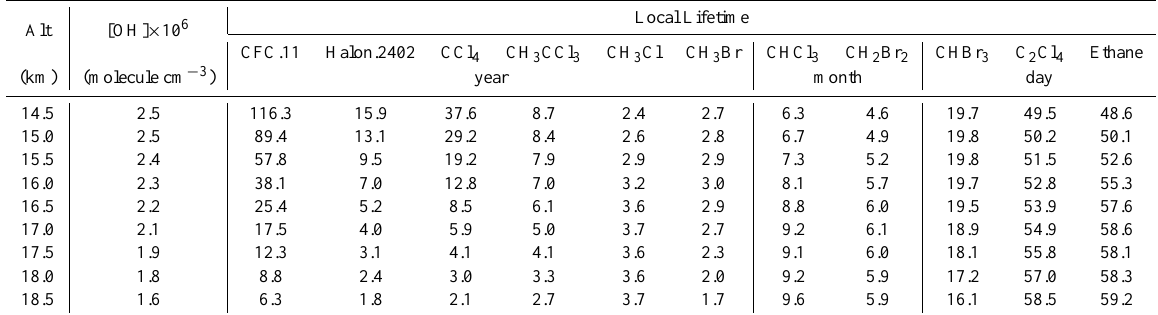
Table 1. Empirically derived OH concentrations with altitude (as shown in Fig. 6). Local chemical lifetimes listed have been averaged into 500-m